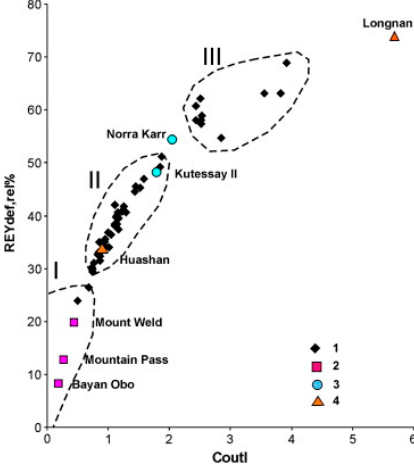
Figure 2. Classification of REY-rich coal ashes by outlook for individual REY composition in comparison with selected deposits of conventional types. 1, REE-rich coal ashes; 2, carbonatite deposits; 3, hydrothermal deposits; and 4, weathered crust elution-deposited (ion-adsorbed) deposits. Clusters of REE-rich coal ashes distinguished by outlook for REY composition (numerals in figure): I, unpromising; II, promising; and III, highly promising. From Seredin and Dai [9].